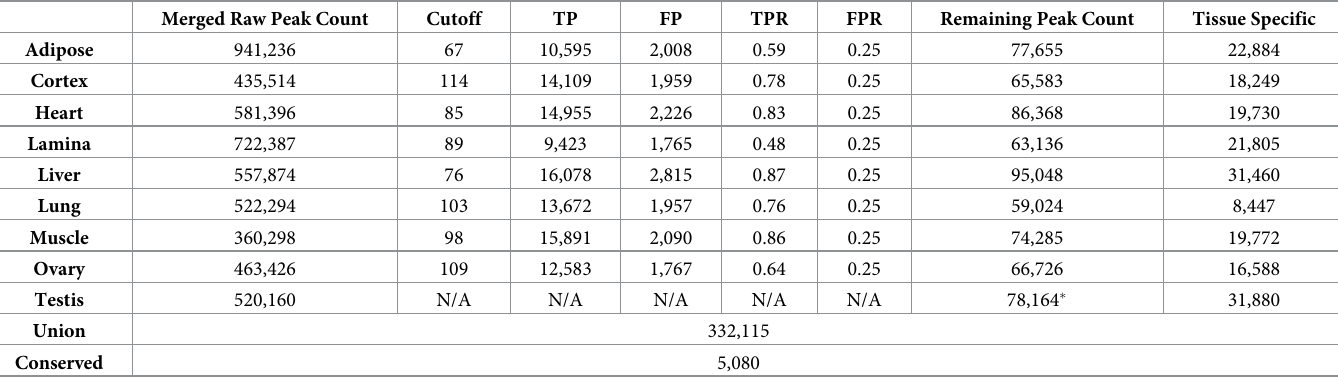
Table 1. Open Chromatin Peak Metrics. Number of peaks identified in each tissue before and after filtering as well as union and tissue-specific peaks. Merged Raw Peak Count